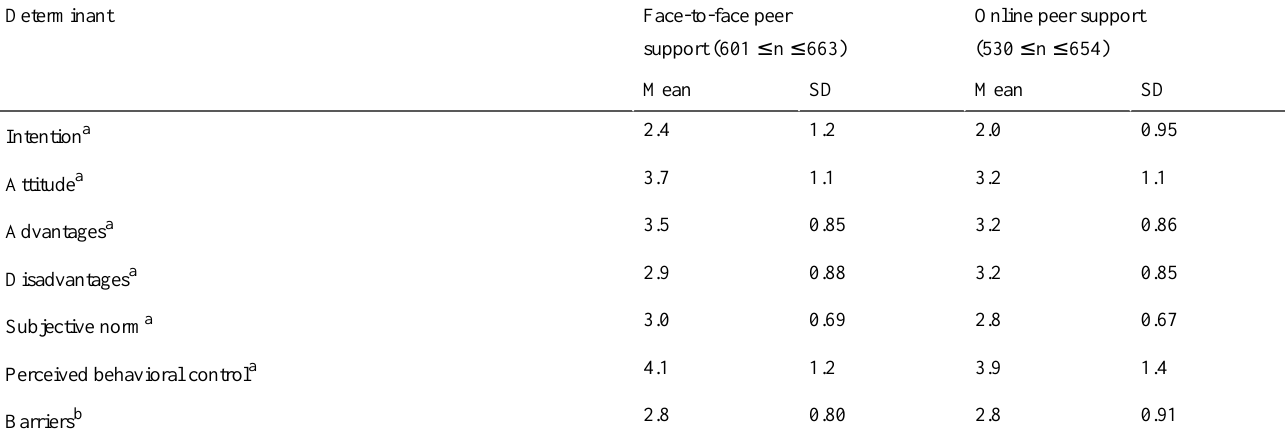
Table 3. Mean scores (range 1–5) for determinants of the theory of planned behavior toward face-to-face and online peer support